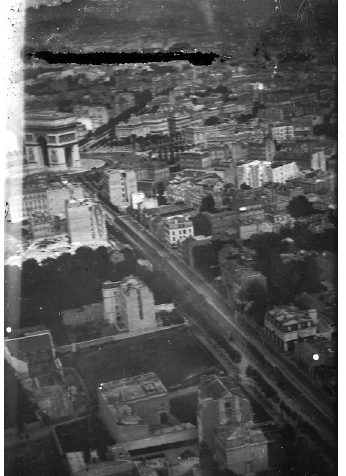
Fig. 1. Paris, Arc de Triomphe , one of the first photographs taken from a balloon by